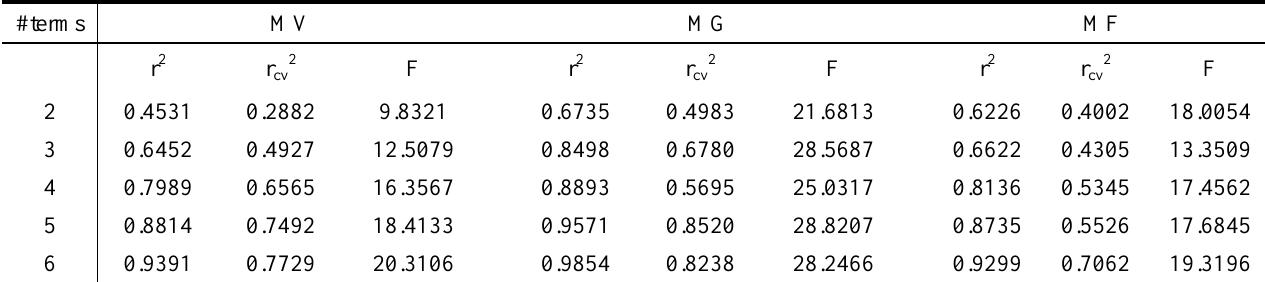
Table 2. Statistical evaluation of QSAR